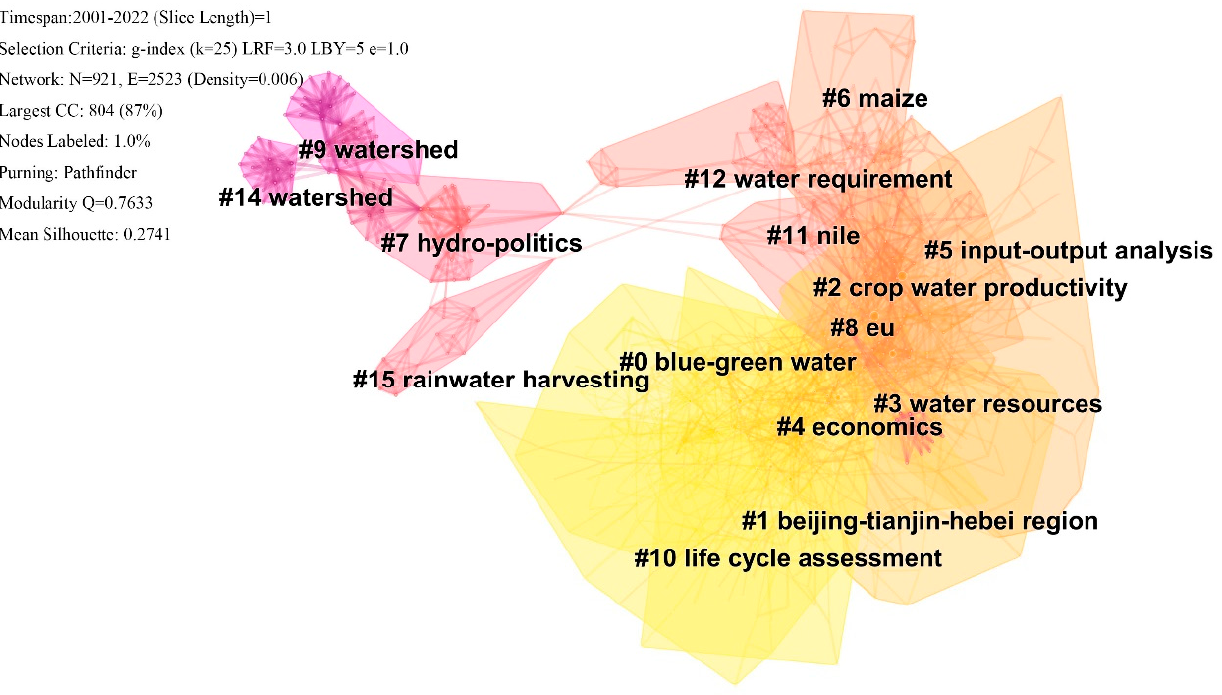
Figure 9. Reference clusters in the field of crop water footprint